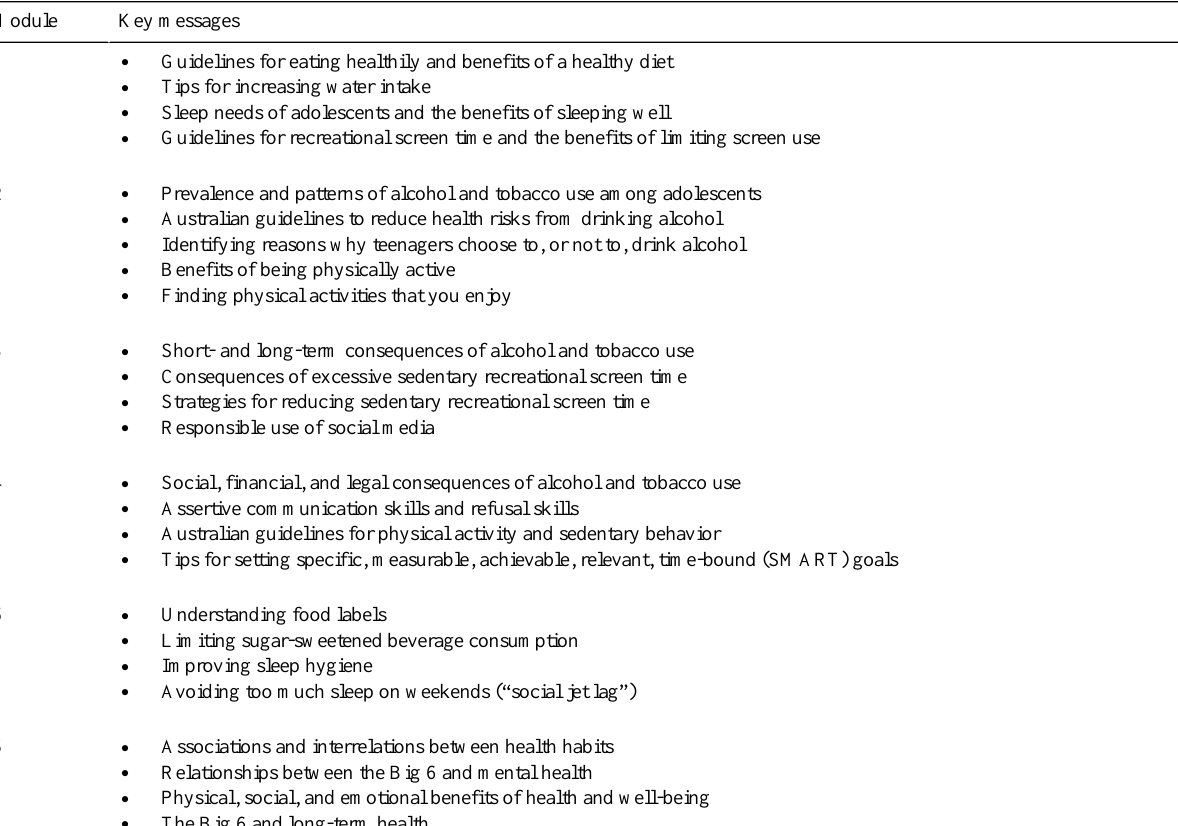
Table 4. Summary of Health4Life program content. Key